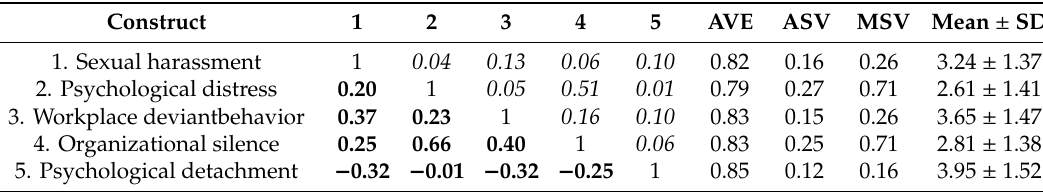
Table 2. Correlation analysis and discriminant validity